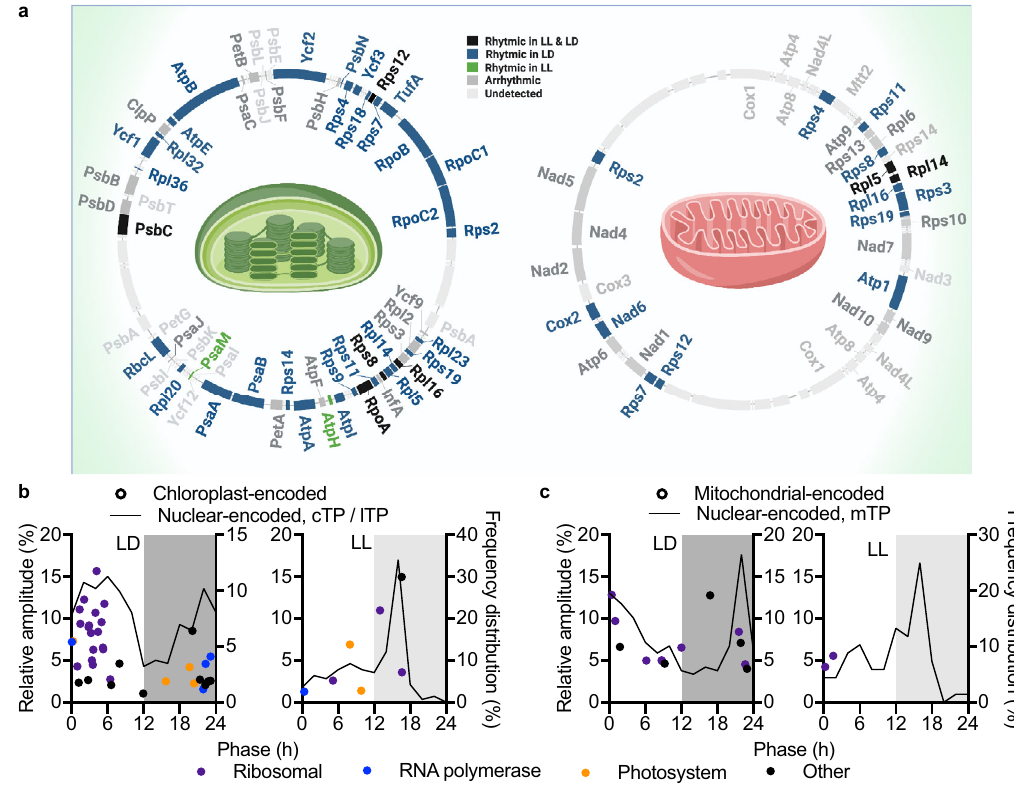
Fig. 6 Orchestrated rhythmicity of organelle-encoded and organelle-targeted proteomes. a Overview of the plastid and mitochondrial genome, with rhythmic, arrhythmic and undetected proteins annotated. b Phase versus amplitude of rhythmic chloroplast-encoded proteins (data points, left Y - axis) under diurnal or constant conditions. Purple dots represent ribosomal proteins, blue RNA polymerases and orange photosystem components. Overlaid is the frequency distribution (black line, right Y -axis) of peak phase for rhythmic nuclear-encoded proteins carrying a chloroplast Transit Peptide (cTP) or thylakoid lumen Transit Peptide (lTP). c Phase versus amplitude of rhythmic mitochondrial-encoded proteins (data points, left Y -axis) under diurnal or constant conditions, overlaid with the frequency distribution (black line, right Y -axis) of nuclear-encoded proteins carrying a mitochondrial Transit Peptide (mTP). Source data can be found in Supplementary Data